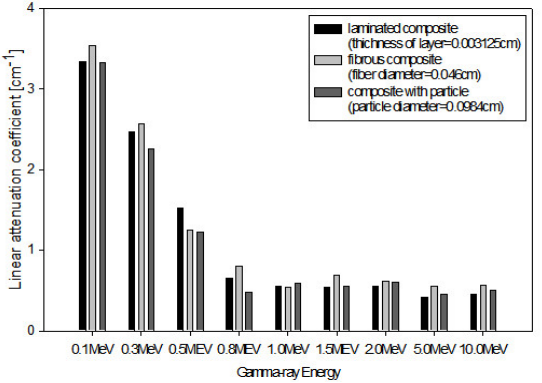
Figure 17. Linear attenuation coefficient of PE/copper composites according to composite structure.